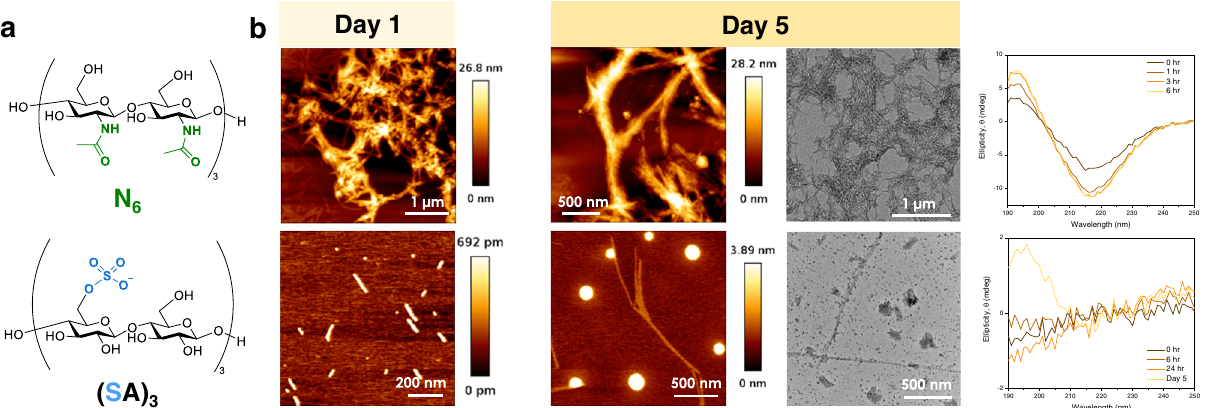
Fig. 5 Exploring the effect of unnatural oligosaccharides on the assembly of R5. a Chemical structure of N -acetyl glucosamine hexasaccharide N 6 and sulfated hexasaccharide (SA) 3 . b AFM (Day 1 and Day 5), TEM (Day 5) images, and CD spectra of fi brils prepared with R5 in the presence of N 6 or (SA) 3